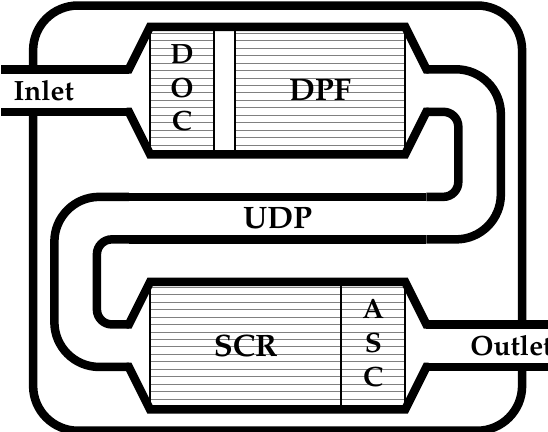
Figure 1. Schematic of the aftertreatment